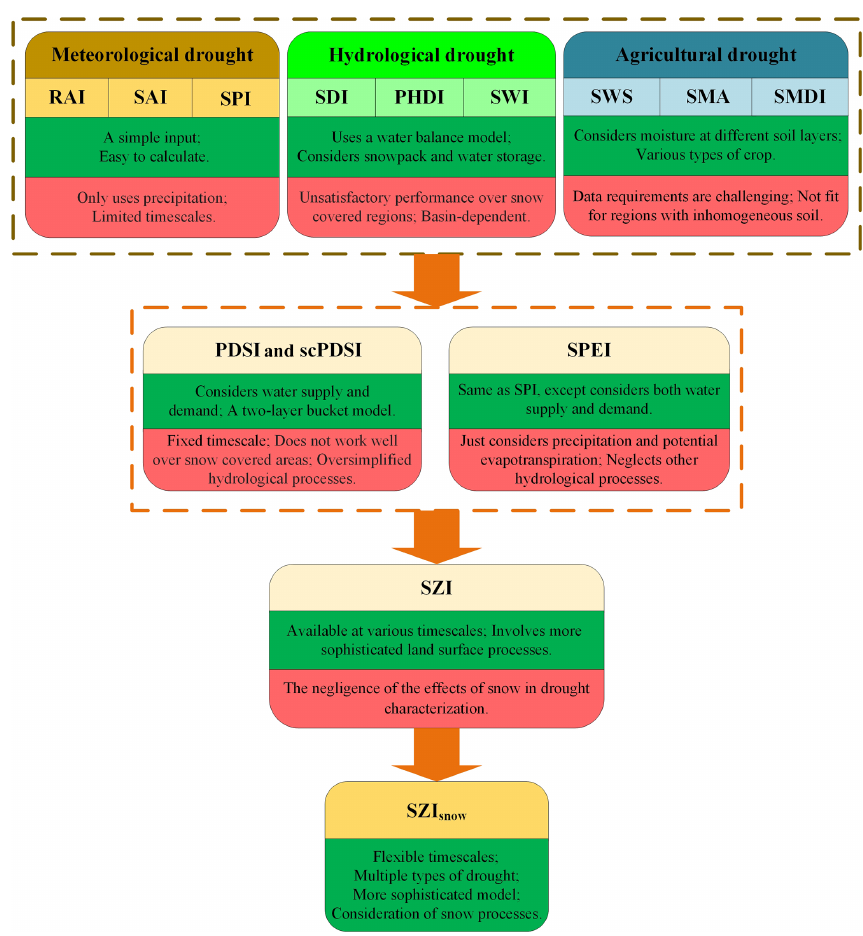
Figure 1. Development path of the SZI snow . Dark green boxes denote the strengths of each drought index, while pink boxes denote the weaknesses of each drought index. The top row shows indices that can only account for one type of drought, with three indices listed for each type of drought. The second row shows indices that can account for multiple types of drought. Full names of the listed indices are shown in Table S1 in the